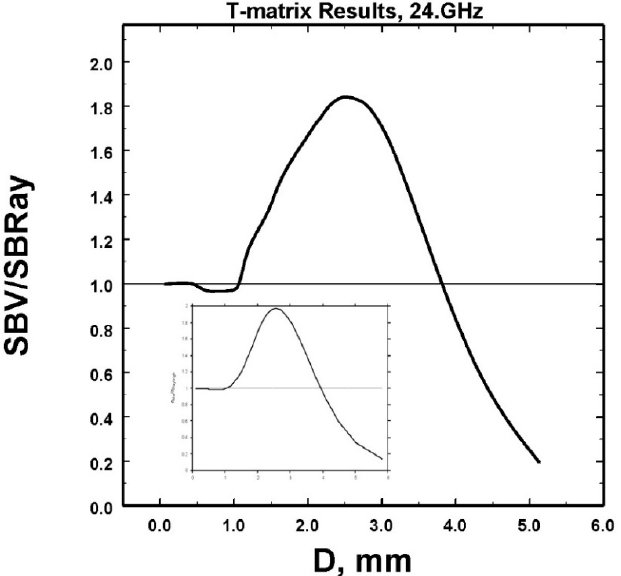
Figure A1. The ratio of the T-matrix calculated backscatter cross-sections for spherical raindrops to that expected if the scattering were Rayleigh. The inset corresponds to that reported in the MRR literature showing that the backscatter cross-sections used in this study are in agreement.